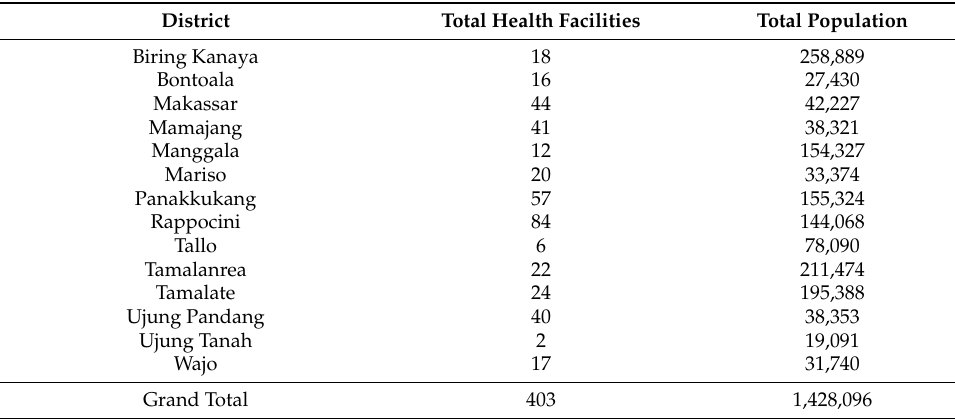
Table 2. Distribution of Health Facilities by